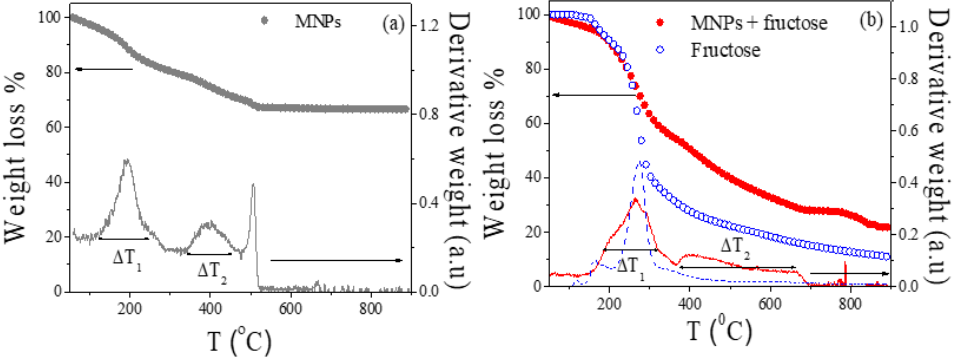
Figure 1. TGA scans for the ( a ) initial Fe 3 O 4 MNPs and ( b ) ( • ) MNPs mixed with fructose. TGA scan for (o) fructose is included for comparison. The derivative of the TGA curves (lines) are also shown (dashed line for the initial fructose).